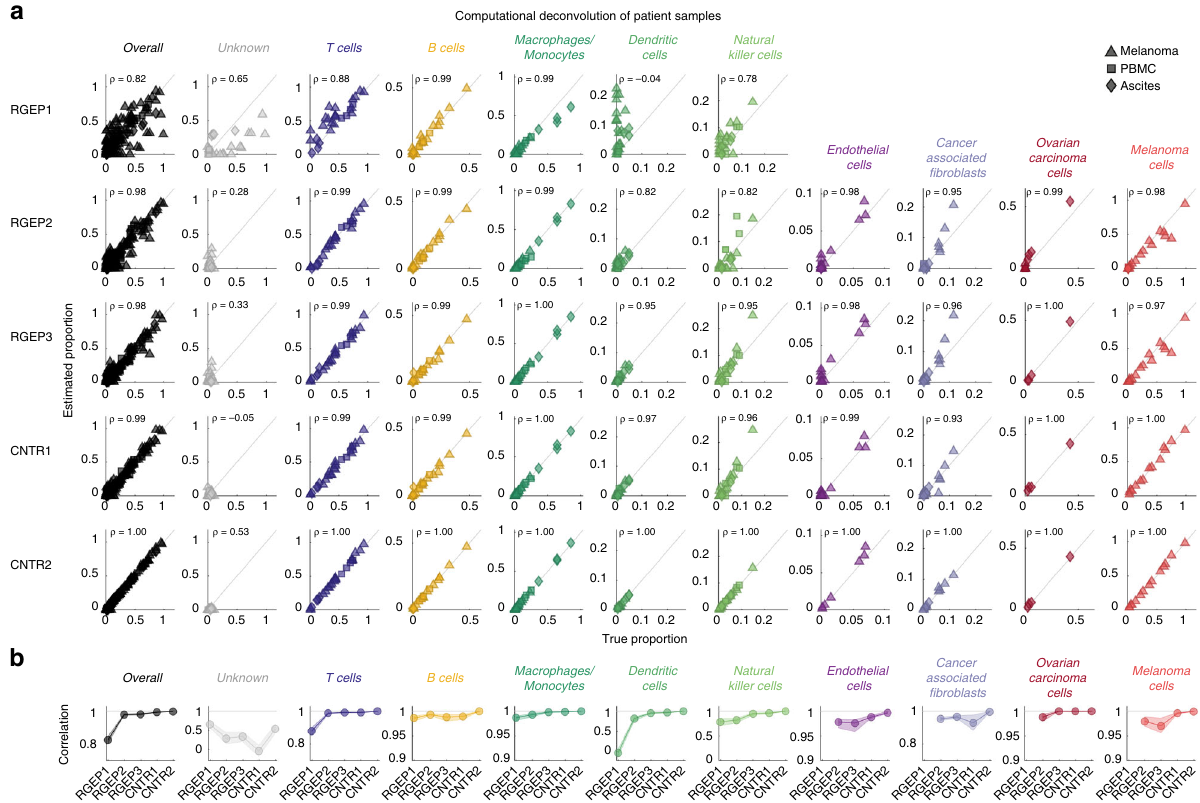
Fig. 4 Estimation accuracy of cellular composition is dependent on the origin and quality of RGEPs. a Scatter plot of true and estimated cell proportions for all 27 patient samples. Each dot represents one patient sample. Values close to the diagonal correspond to high deconvolution accuracy. Columns depict cell types; rows describe the fi ve different con fi gurations (REGP1-3 and CNTR1-2). ρ denotes the Pearson ’ s correlation coef fi cient. In con fi guration REGP1, estimates for tumour-associated cell types are not available. b Pearson ’ s correlation coef fi cient between estimated and true cell fraction for all fi ve con fi gurations. Dots denote the median of the correlation coef fi cient; the shading represents the uncertainty based on bootstrapping (upper and lower quartile). (Please note the different scaling of the fi gure